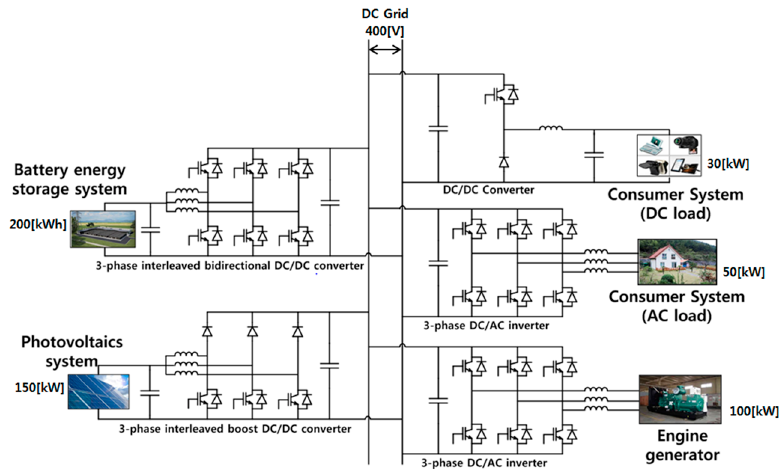
Figure 1. Stand-alone DC microgrid on a remote island.